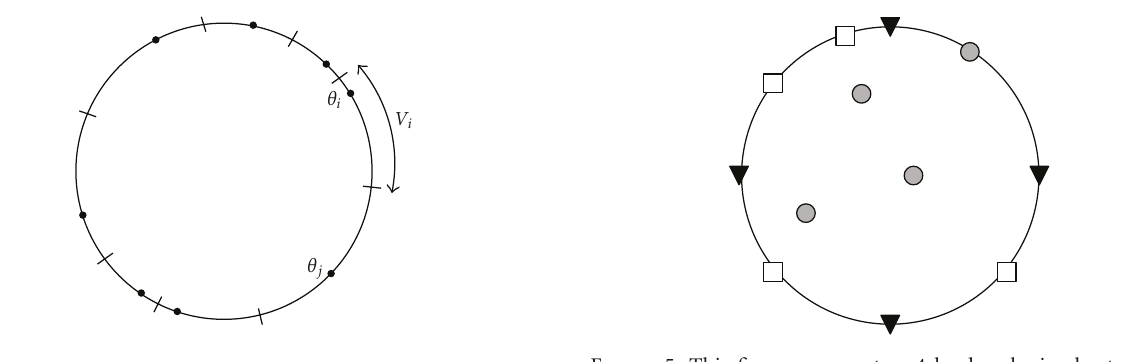
Figure 5: This figure represents a 4-landmark circular topology. Triangles, squares, and circles, respectively, represent the UniBound , RandBound , and Rand landmark placement